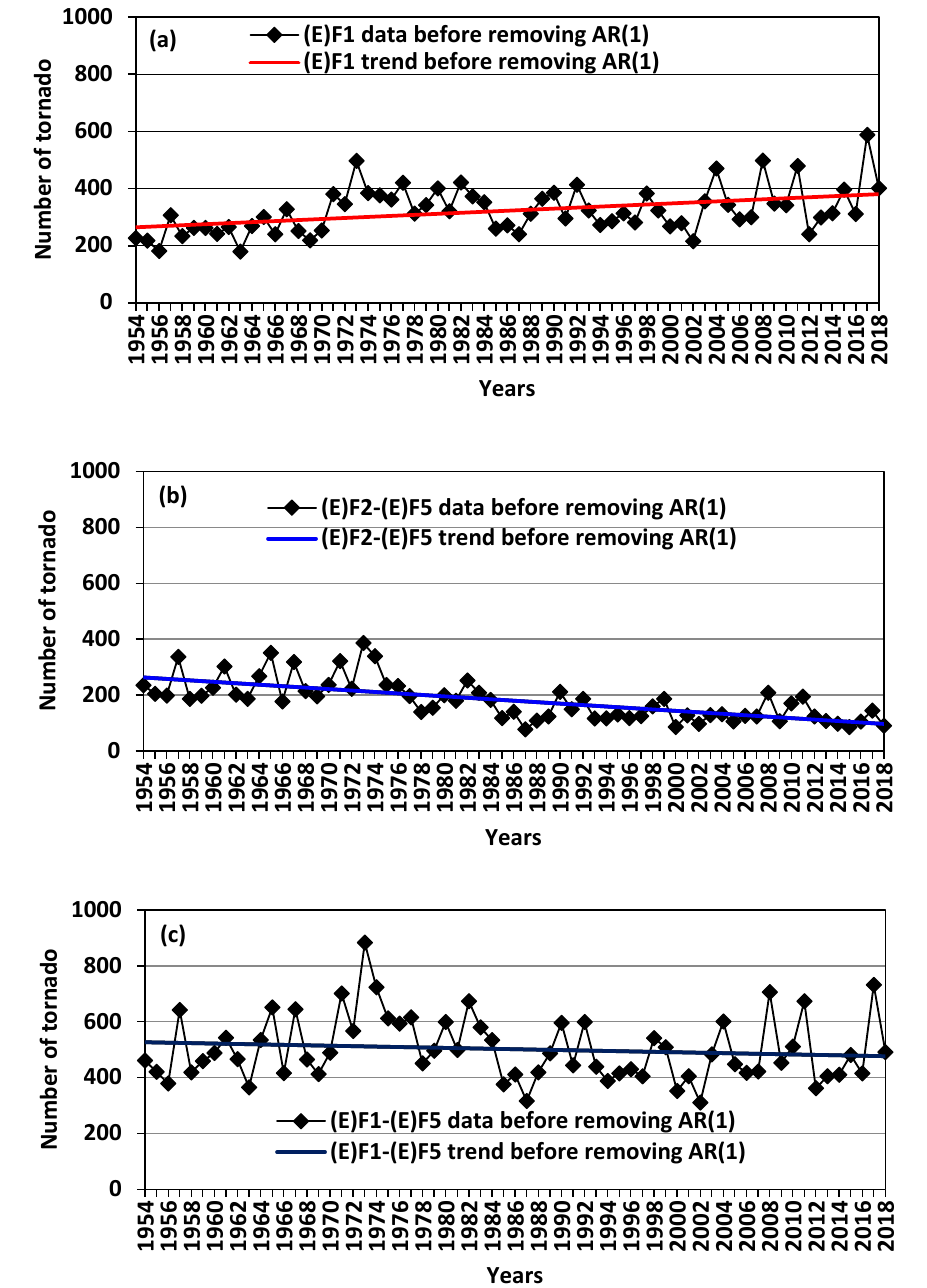
Figure 5. Time series of U.S. tornado counts (1954–2018) and its trend after removing tornadoes. occurred in a major tornado outbreak of 25–28 April 2011 and before removing AR(1) for ( a ) (E)F1 tornado, ( b ) sum of (E)F2 to (E)F5 tornado, and ( c ) sum of (E)F1 to (E)F5 tornado. In addition to U.S. tornado count trends, we also examined U.S. tornado trends from the tornado day [6,29,30,32] perspective, ranging from low frequency (e.g., a tornado day with one tornado at least on that day) to high frequency (e.g., 10+, 20+, 30+, 40+, and 50+ tornado